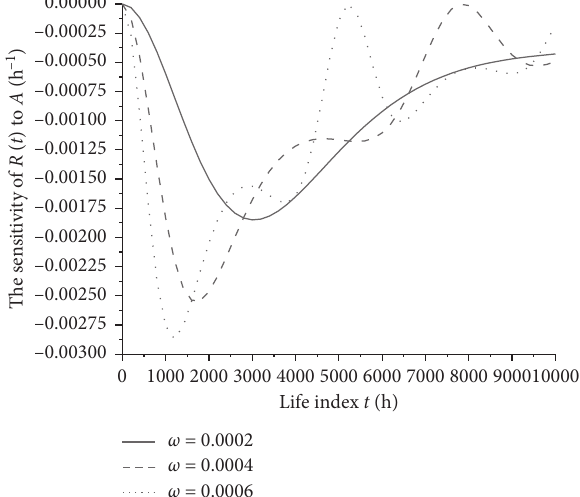
Figure 35: The sensitivity of R ( t ) to A ( ω � 0.0002/0.0004/0.0006).